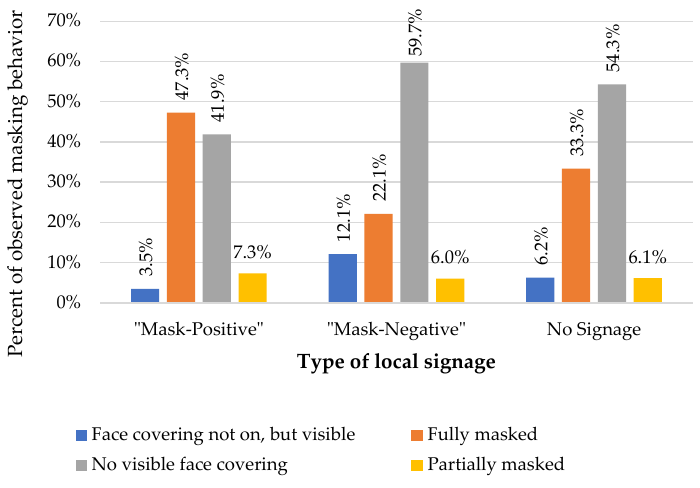
Figure 3. Masking behavior observed by local signage. Unadjusted and adjusted odds ratios and 95% confidence intervals for the key pre- dictor variables of interest are shown in Table 2. The fully adjusted model revealed a 58.8% increase in the odds of full masking during observation period 2 and a 52.7% increase during observation period 3, as compared to observation period 1. The model also re- vealed a statistically significant increased odds of full masking amongst Asians, Black/Af- rican Americans and “other” racial groups, as compared to the W hite population. Seniors were significantly more likely to fully mask compared with adults (OR = 1.71; 95% CI 1.47, 2.00) and females were 49% more likely to fully mask compared with males and 56% more likely than males to wear any mask (full or partial). Other significant predictors included increased odds of masking on weekends, compared with weekdays, presence of positive signage, Publix compared with Walmart, and full masking was more likely among those who observed physical distancing. Table 2. Masking by observation period — full mask and any mask (unadjusted and adjusted). Variable Full Mask Overall OR (95% CI) Any Mask Overall OR (95% CI) Unadjusted Models Observation Period 1